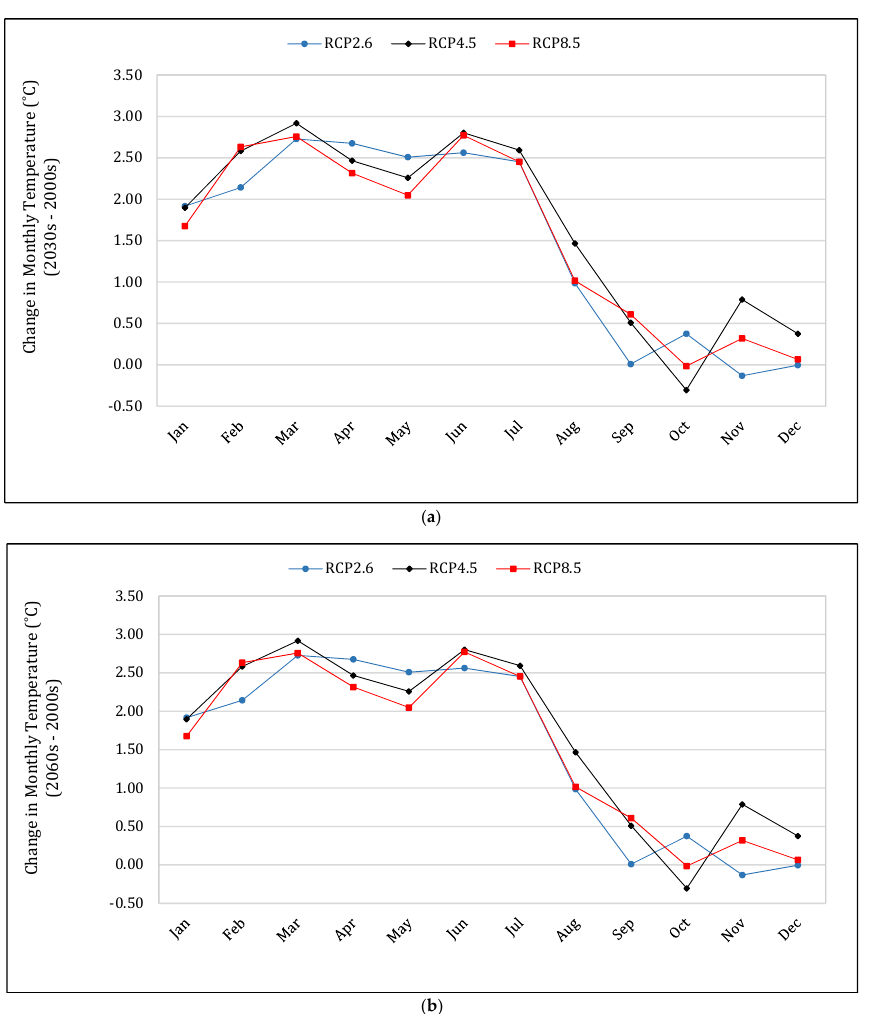
Figure 4. Projected change in monthly temperatures during 2021–2050 ( a ), and 2051–2080 ( b ) in the eastern zone (Alliston) compared to those that prevailed during 1991–2020.